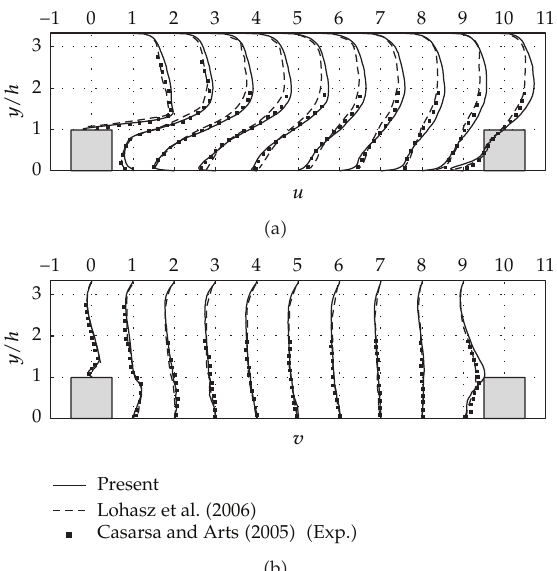
Figure 3: Comparison of streamwise and cross-stream velocity with the reference data (cid:2) all results are at Re (cid:8) 12 , 000 (cid:3)